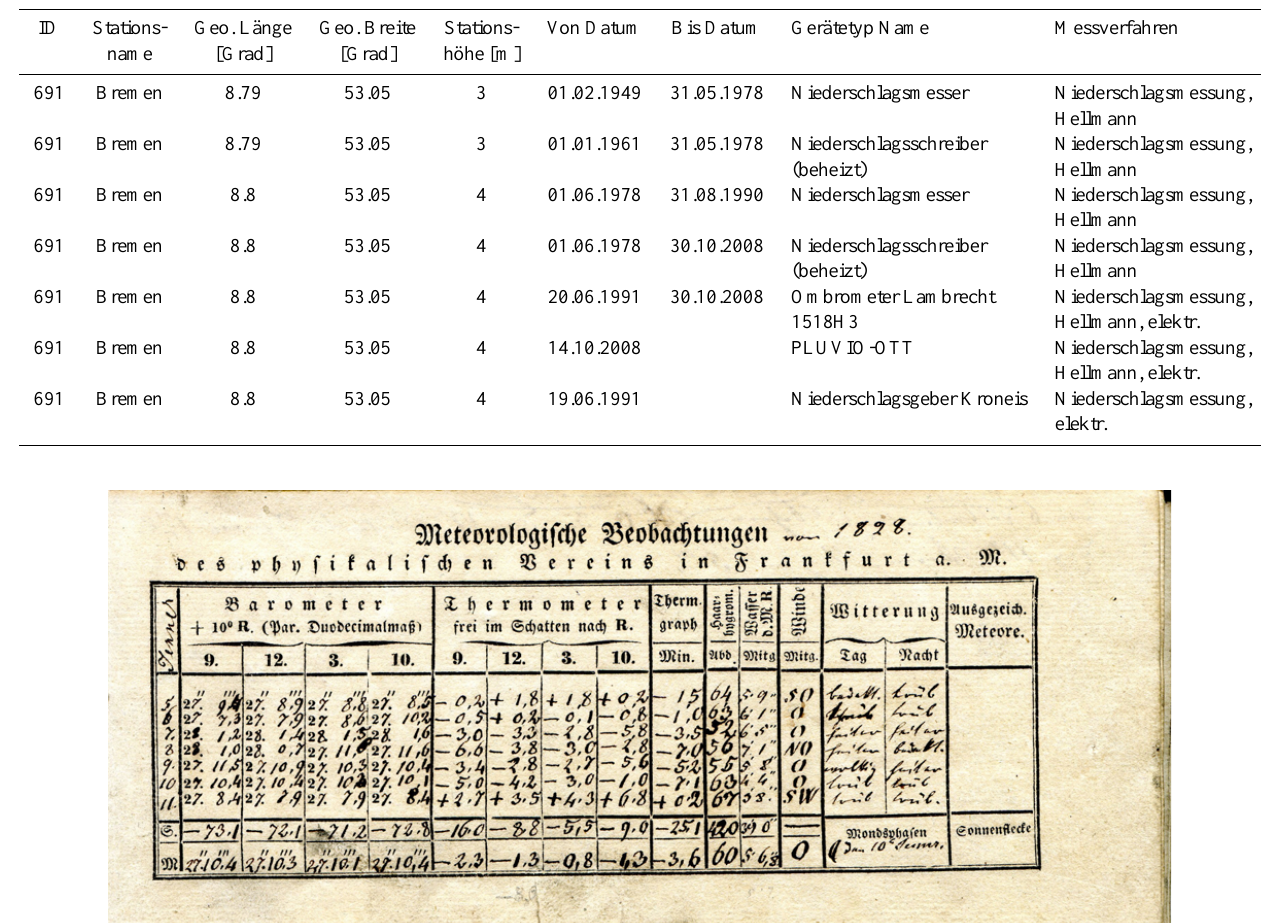
Table 3. An example for the provision of supplementary metadata on station / instrumentation history: instruments used to measure precipita- tion at station Bremen. Further metadata, e.g. observation times, are provided in additional tables (table is shown as provided with the data, i.e. in German language).